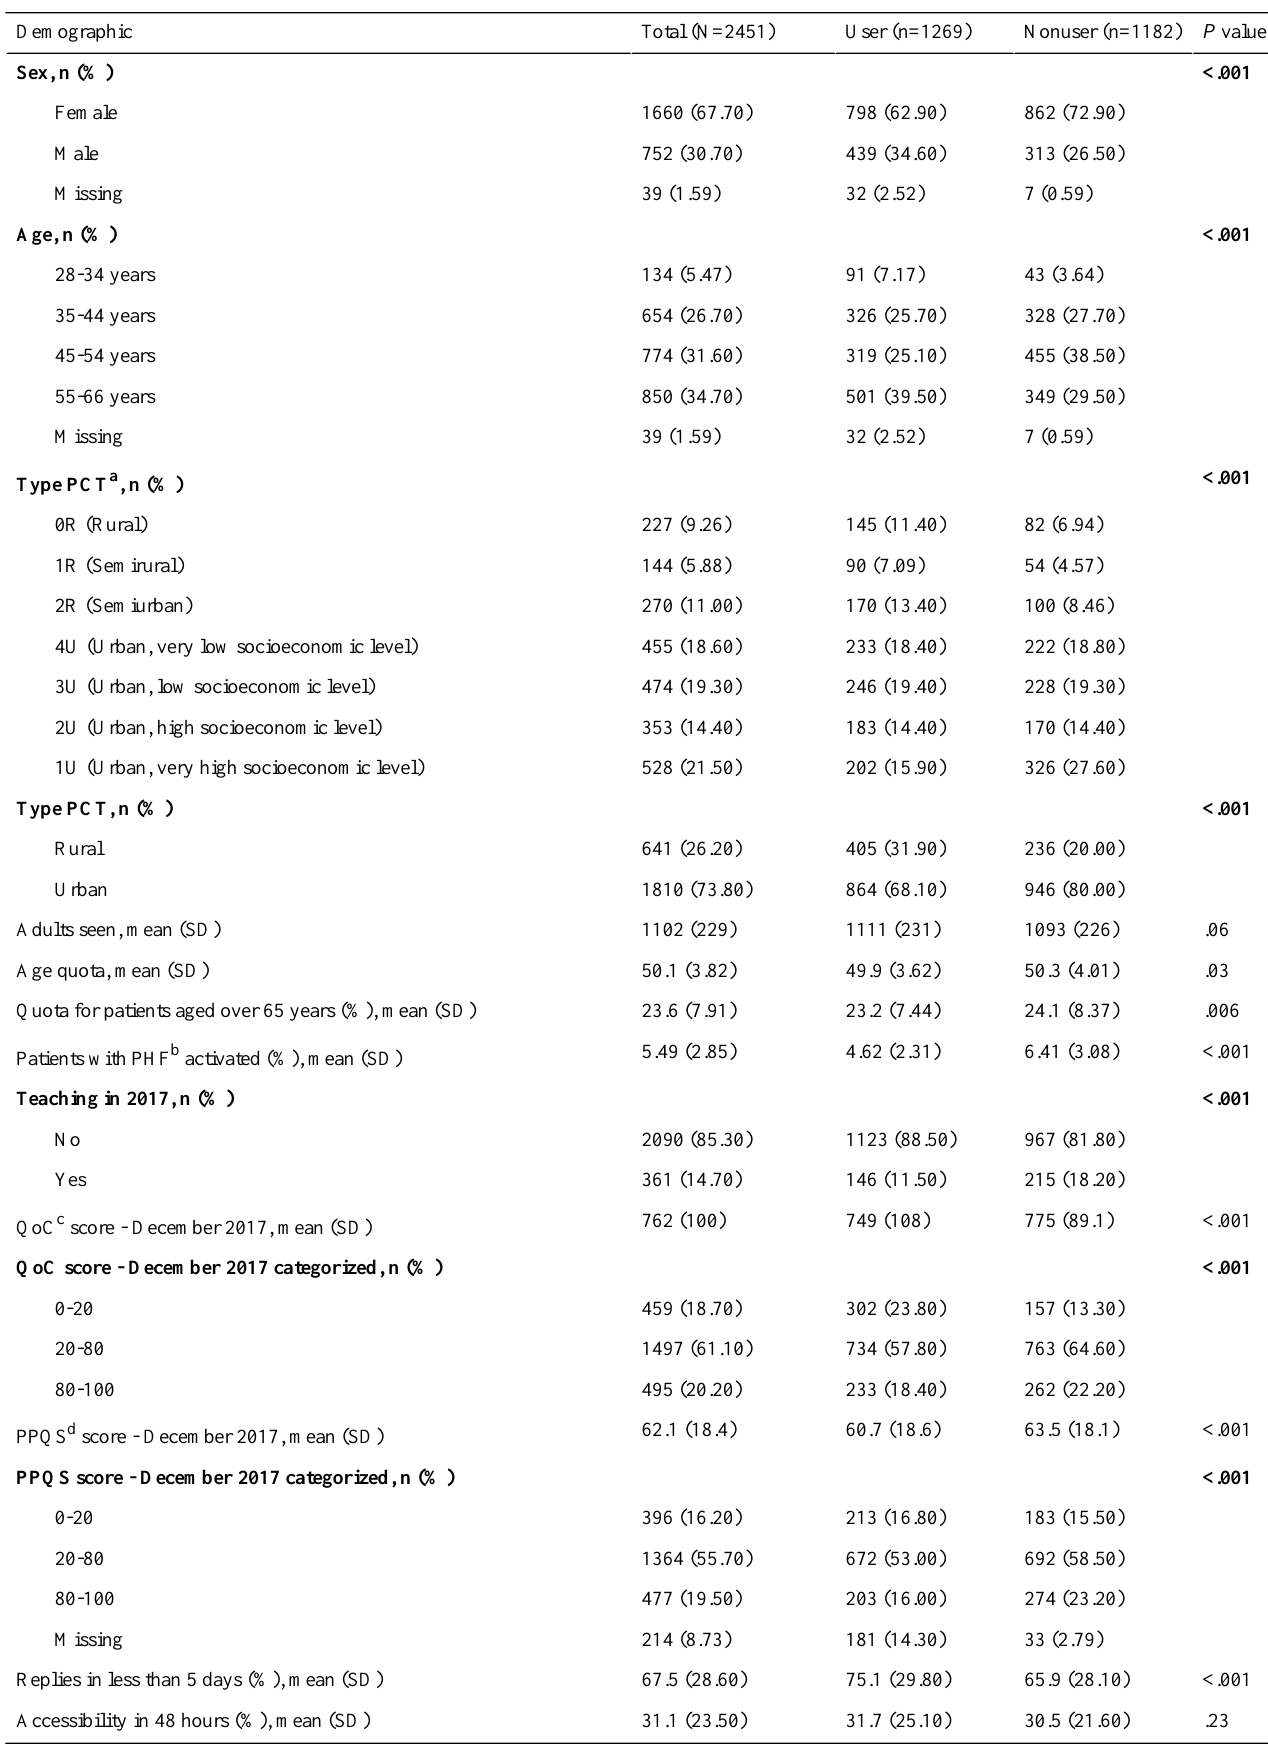
Table 2. Sociodemographic characteristics of doctors by use of